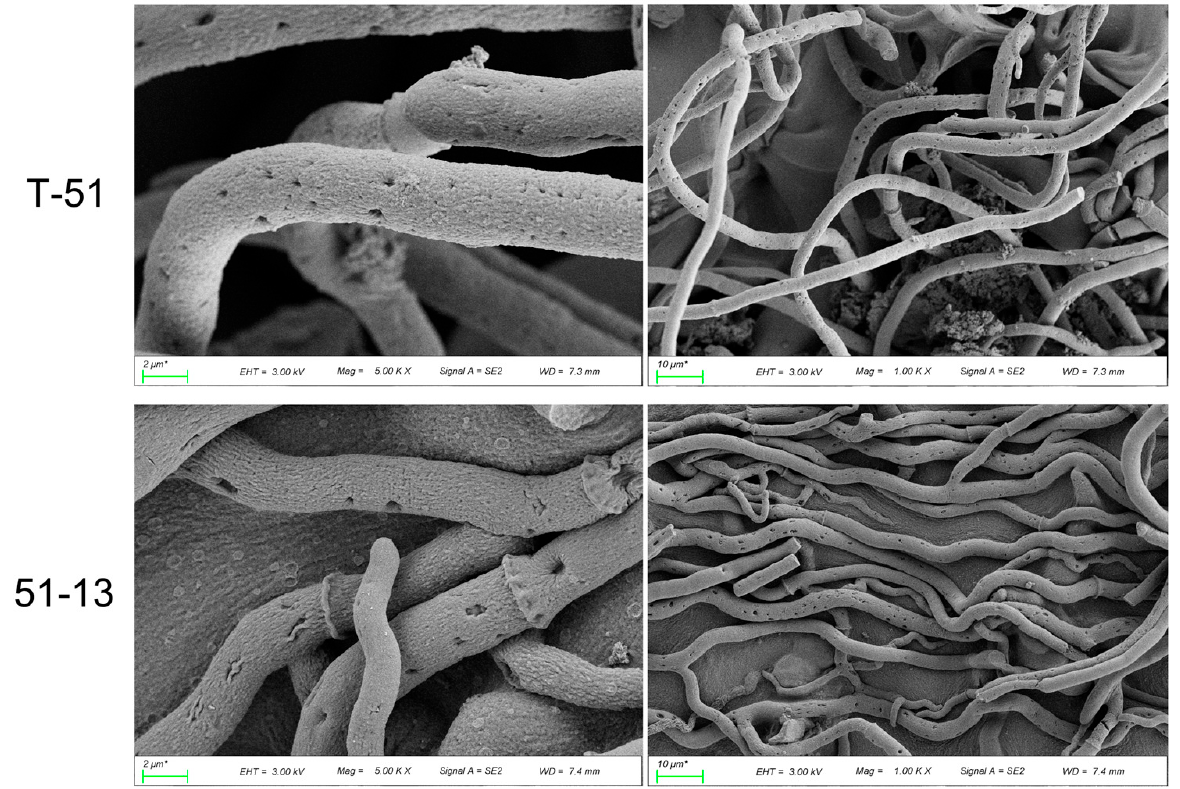
Figure 1. Mycelial morphology of T-51 and 51-13 observed using SEM.